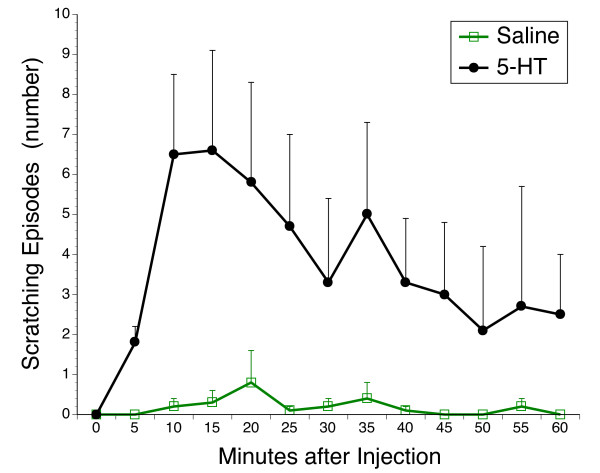
Time course of the scratching response to subcutaneous 5-HT. Number of episodes of scratching in 5-min intervals over a one-hour period after injection of 5HT subcutaneously. (n = 5 per group) Controls got an injection of an identical volume of saline (100 μl).